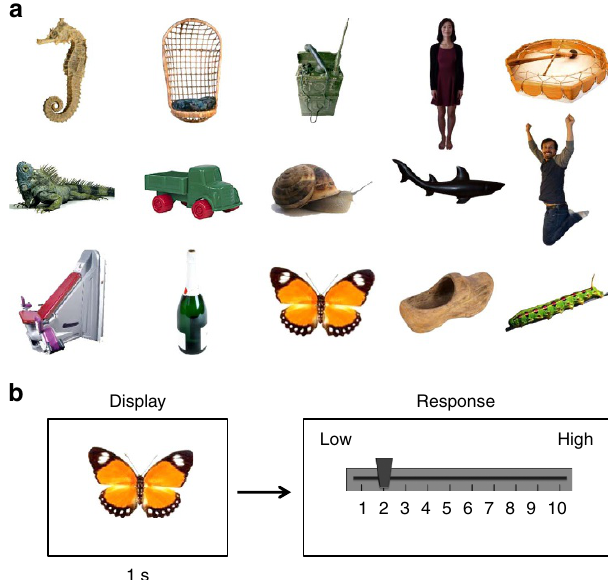
Figure 1 | Stimuli and trial sequence in Experiment 1. ( a ) Example images illustrating the diversity of stimuli used in the experiment (out of 150 total). The images exhibit a wide variety of physical features, and some stimuli may be associated with both living and non-living attributes. Some images used in the actual experiments are replaced in these figures due to copyright. ( b ) Experiment 1 trial sequence. Participants viewed a random stimulus for 1s and then rated it on a Likert scale of lifelikeness using a slider